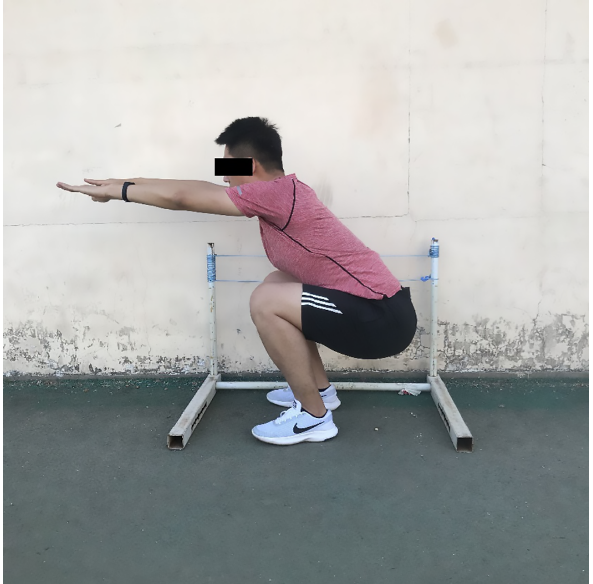
Fig. 8. Below the marking